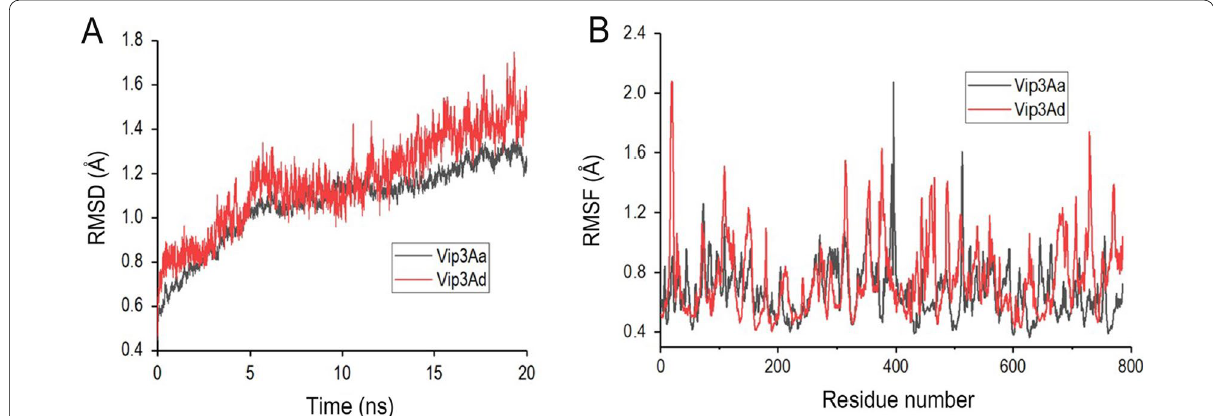
Fig. 3 The RMSD ( A ) and RMSF ( B ) values of Vip3Aa and Vip3Ad based on 20 ns MD trajectories. The temperature was set as 303